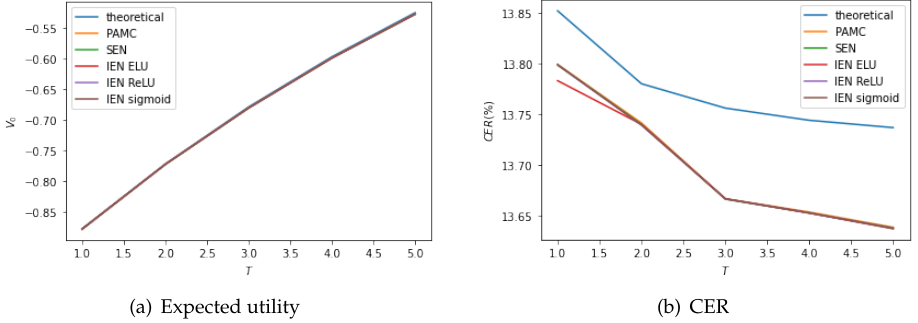
√ X t , where ( a ) shows the expected